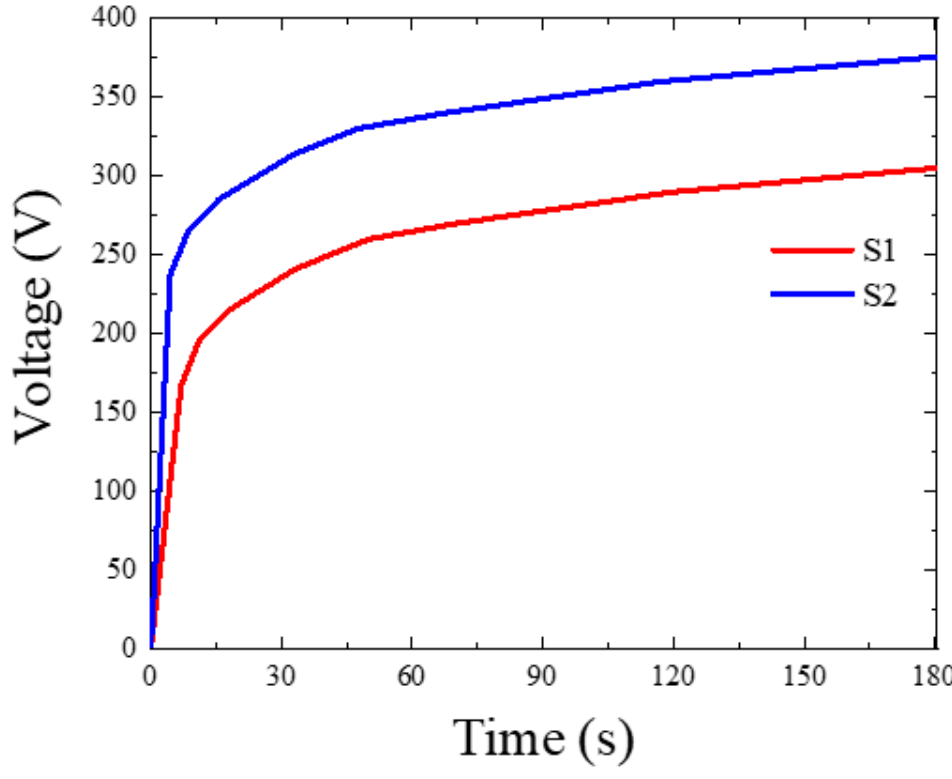
Figure 1. Voltage–time response during MAO treatment of the S1 and S2 samples.